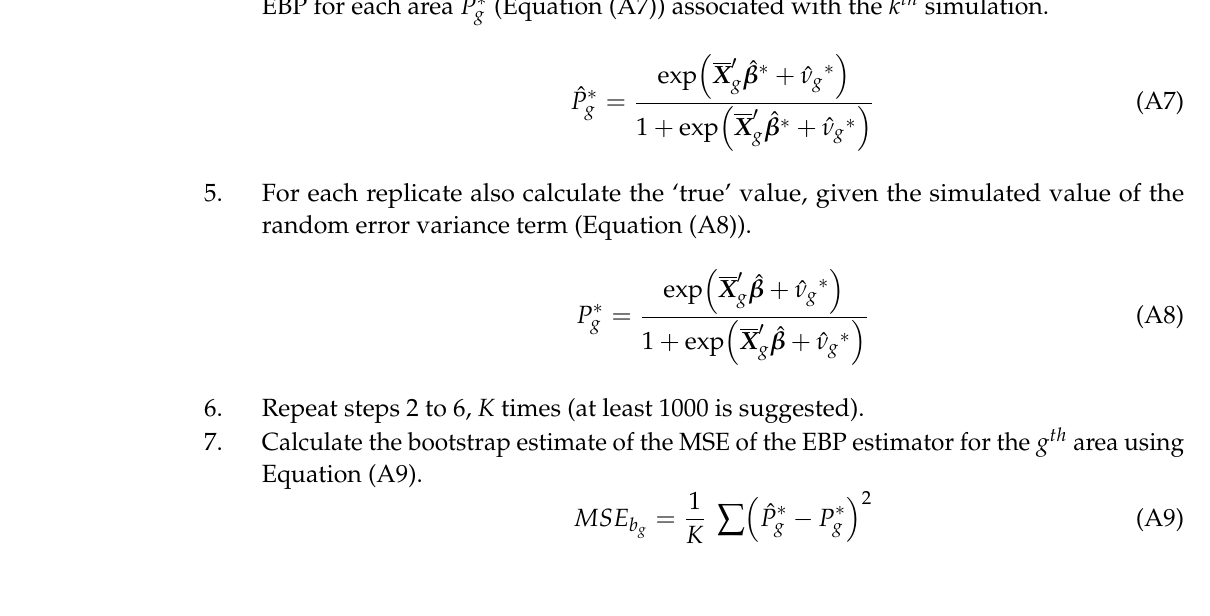
Repeat steps 2 to 6, K times (at least 1000 is suggested). Calculate the bootstrap estimate of the MSE of the EBP estimator for the g th area using Equation